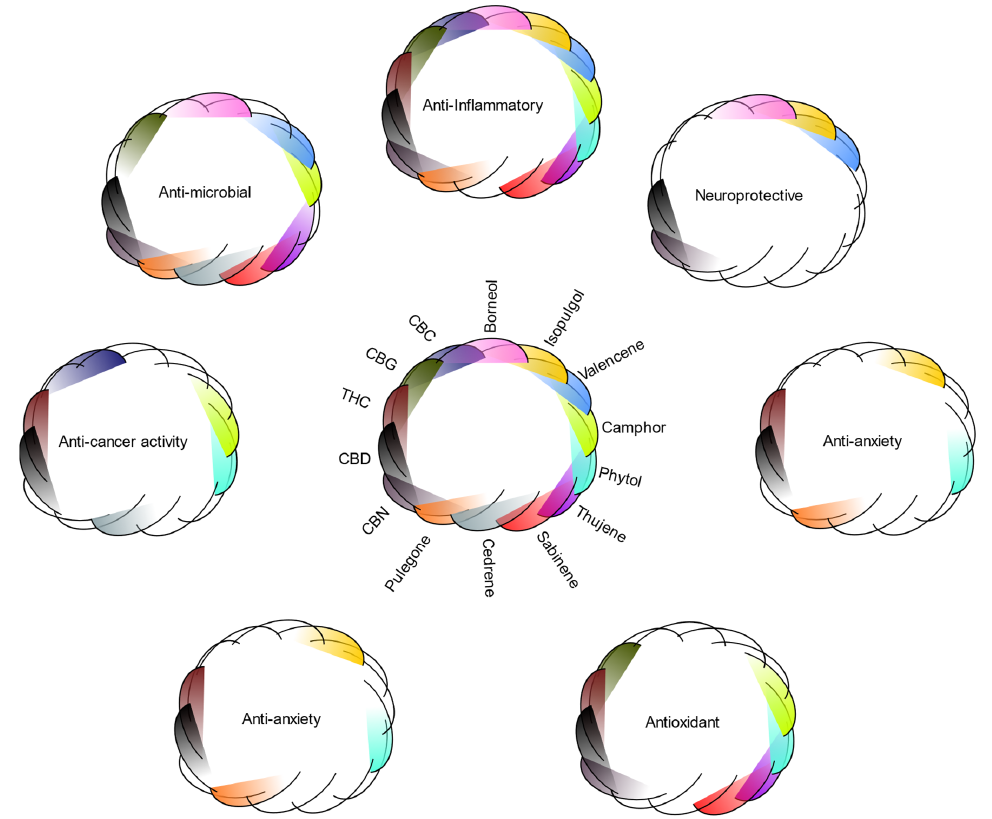
Figure 3. Bioactivities of the nine secondary terpenes covered in this review, along with cannabis’s principal cannabinoids (CBD, cannabidiol; THC, tetrahydrocannabinol; CBG, cannabigerol; CBN, cannabinol; CBC, cannabichromene). Bioactivity circles are color-coded to match the legend in the middle; the presence of a particular shading in the circle is indicative that the terpene or cannabinoid has been reported to possess that bioactivity. The figure demonstrates that not only do terpenes have multiple potential bioactivities, but different compounds possess overlapping activities, suggesting their potential to exert combination effects.